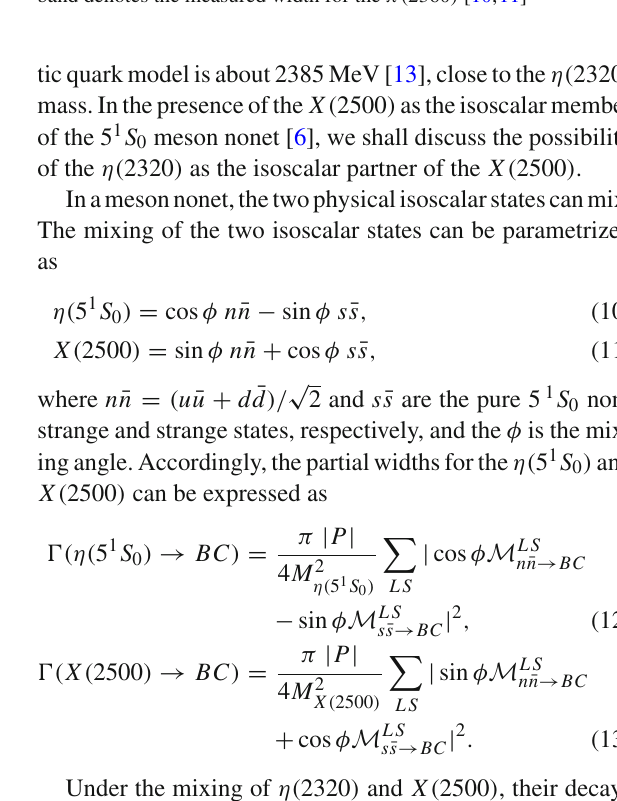
Fig. 2 The dependence of the π( 5 1 S 0 ) total width on the initial state mass in the 3 P 0 model with two types of wave functions. The yellow band denotes the measured width for the π( 2360 ) [10,11]